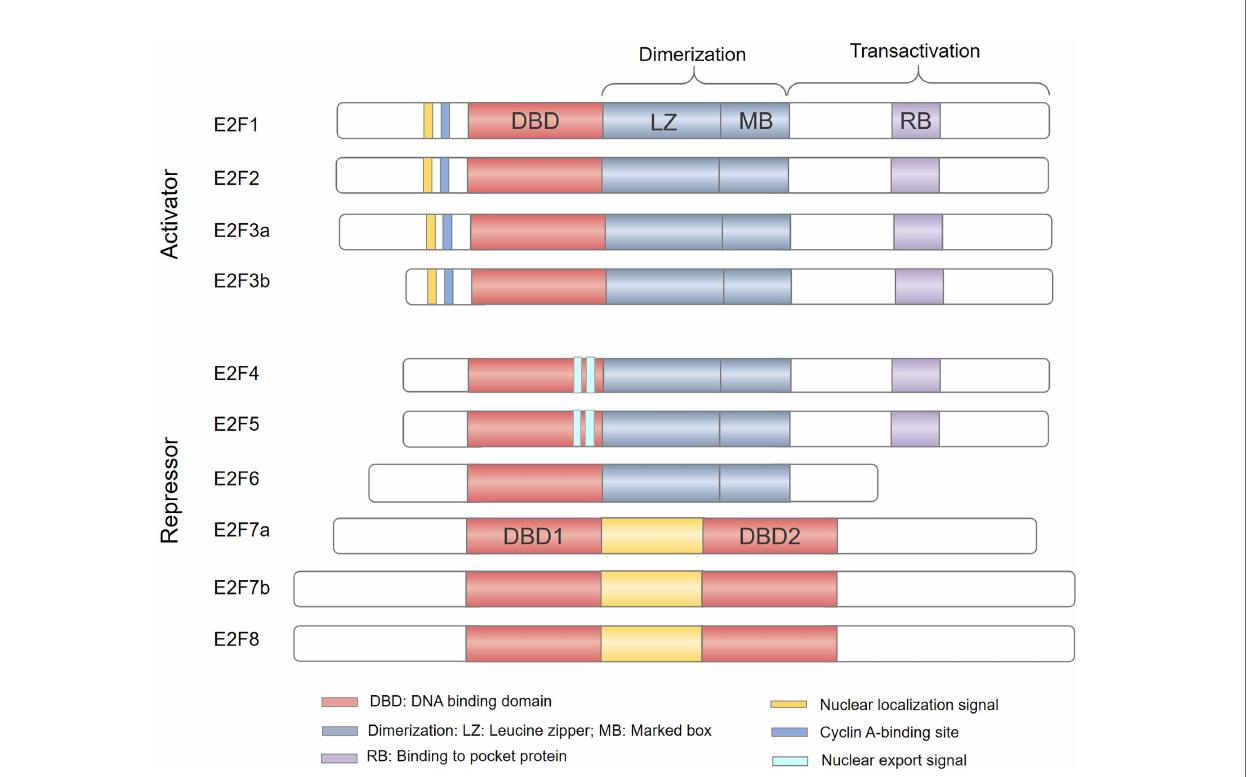
FIGURE 1 | The E2F family of transcription factors. Based predominantly on the results of in vitro studies, E2Fs are generally divided into transcriptional activators (E2F1-3) and transcriptional repressors (E2F4-8). E2F family members E2F1 – E2F6 contain a distinctive winged-helix DNA binding domain (DBD) and a dimerization partner (DP) binding domain composed of a leucine zipper (LZ) and a marker box (MB) domain to bind DNA. In addition, E2F1-5 has a pocket protein (RB, p107 and p130)-binding domain in the transactivation domain; the minimum site is shown in light purple (RB). E2F1-3 also have a nuclear localization sequence (NLS) and a Cyclin A-binding site, while E2F4-5 have a nuclear export signal (NES). E2F7-8 have two tandem DBDs but lack dimerization and transactivation domains and do not bind to DP or pocket